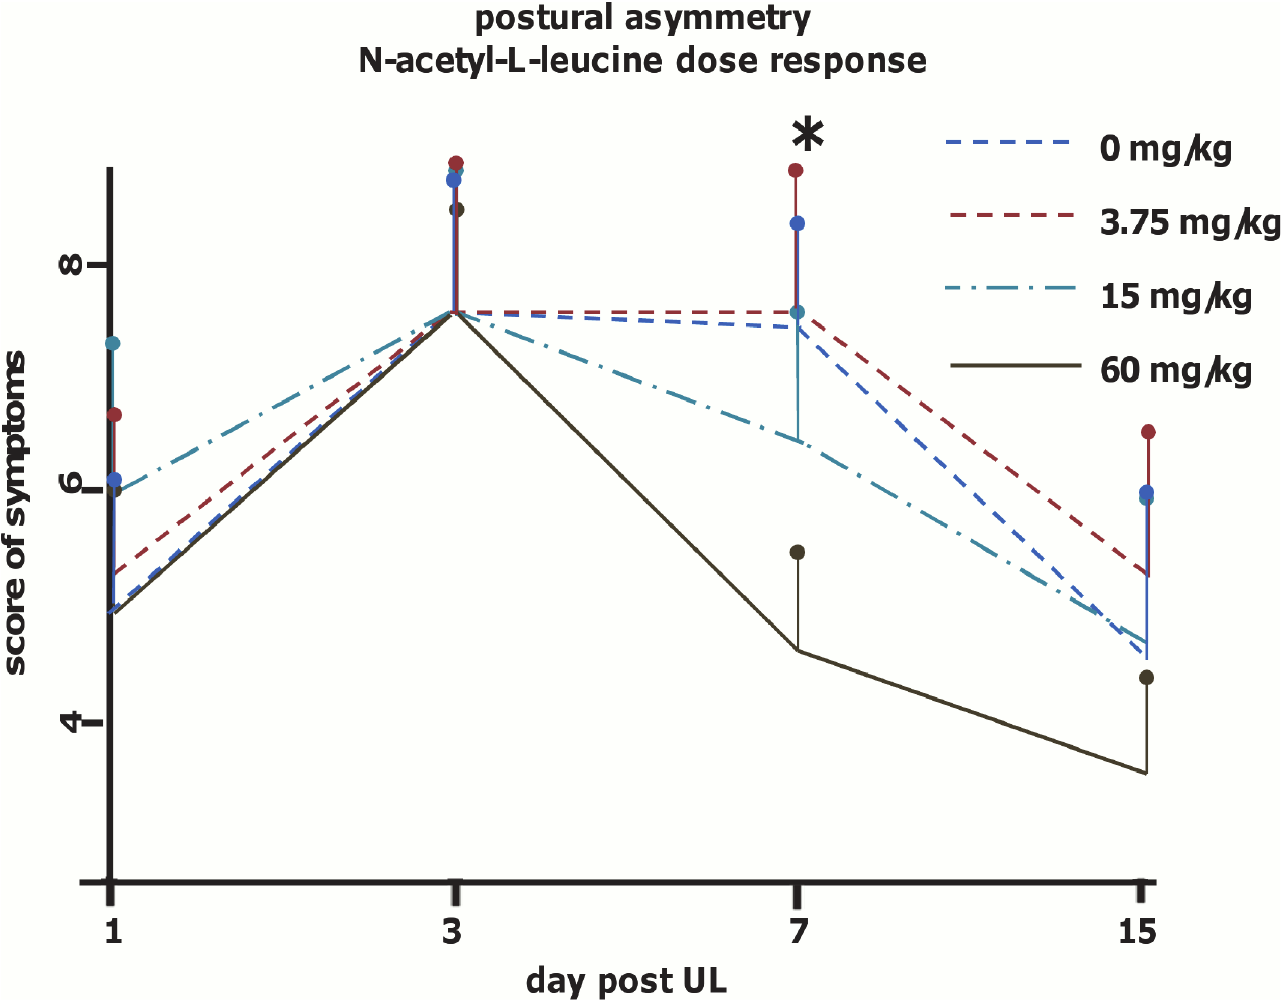
Fig 3. Dose-dependent effects of N-acetyl-L-leucine on postural compensation after unilateral labyrinthectomy. Sham treatment (vehicle) and N- acetyl-L-leucine (3.75, 15 or 60 mg/kg) was administered i.v. on days 1, 2 and 3 (six animals per group). Postural imbalance scores were analyzed in all groups on days 1, 3, 7 and 15. Postural imbalance was significantly decreased in the 60 mg/kg (p < 0.004) but not in the 15 mg/kg or 3.75 mg/kg group. Values are depicted as mean, the standard deviation as error bars. Significant values (60 mg/kg vs. vehicle and 60 mg/kg vs. 3.75mg at day 7) are marked with an